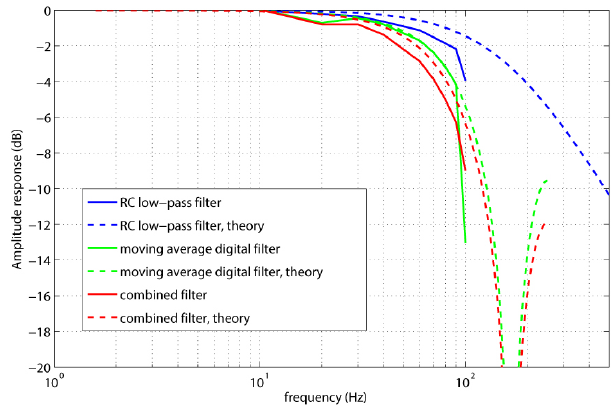
Fig. 16. Amplitude response of the applied filters in the analog channels of the MASC DAQ. The effective filter (red) is a com- bination of an analog RC low-pass filter (blue) and a digital moving average filter (green). The dashed lines represent the theoretical be- haviour of the filters with the applied parameters. The solid lines represent measurements of the real sensor response in an acoustic box experiment.